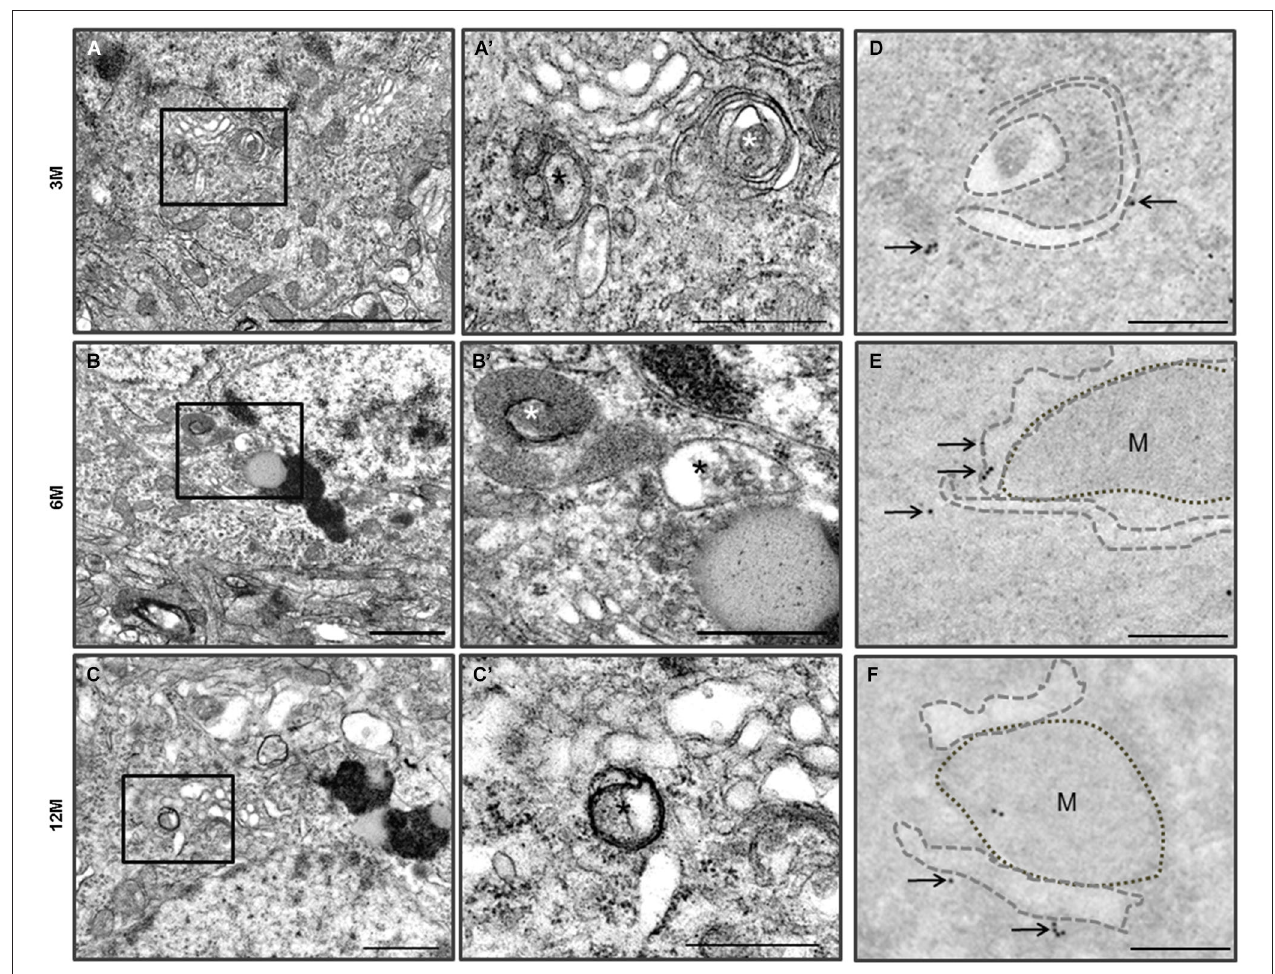
compared to the solid line boxes in the (A–C) . (D–F) LC3B immunogold particles (arrows) were localized on the membranes and phagophores (dotted lines) in the degenerated cortical neurons, which were undergoing autophagy. M: mitochondria. Scale bars, 2 µ m for (A) ; 1 µ m for (B–C) ; 500 nm for (A’–C’) ; 200 nm for (D–F)